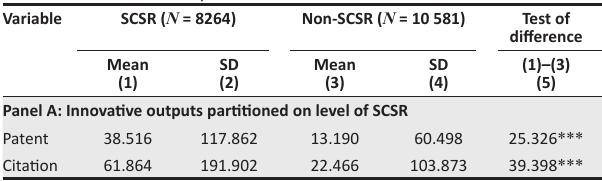
TABLE 2A: Univariate analyses.